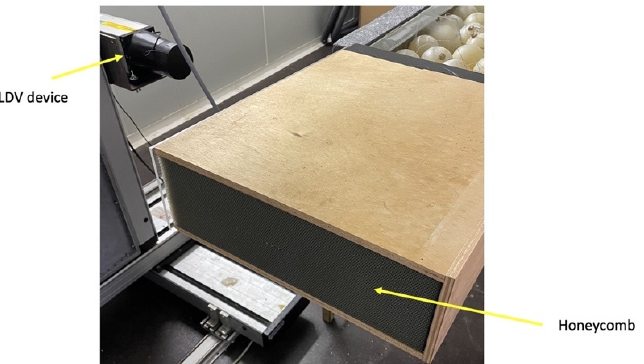
Figure 3. Image of the LDV measuring device and the honeycomb at the inlet of the tunnel.